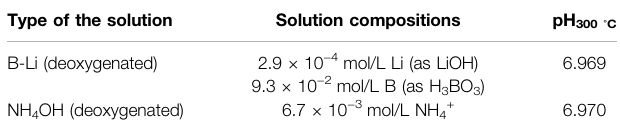
TABLE 2 | Aqueous solutions compared in this study.